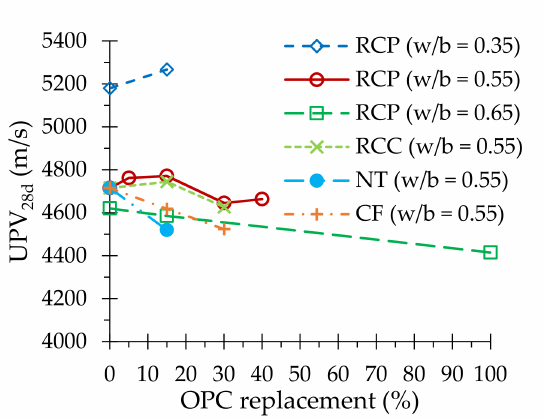
Figure 21. Ultrasonic pulse velocity at 28 days, UPV 28d , of concrete with different incorporation percentages of additions.